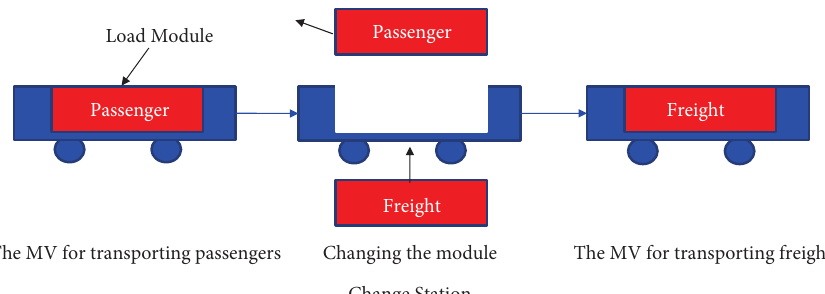
Figure 2: Schematic concept of multi-purpose